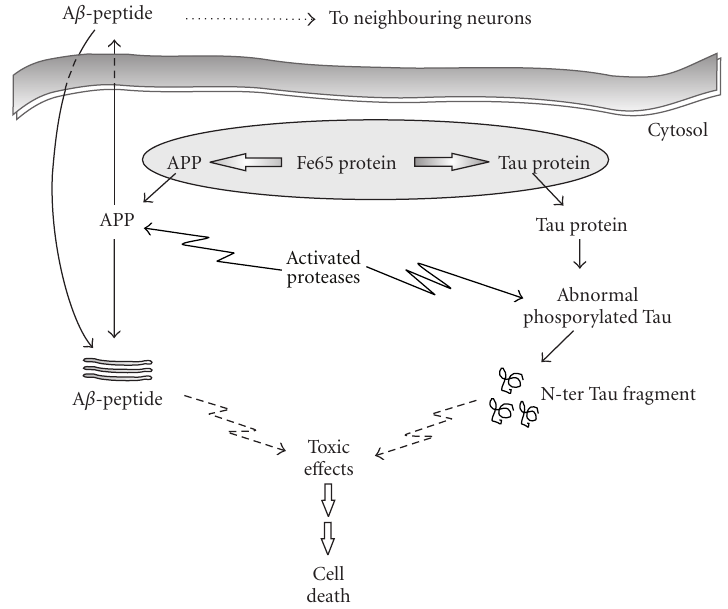
Figure 1: Schematic overview of A β peptide and Tau fragments production in CGNs. A β is produced intracellularly or taken up from extracellular sources and together with Tau fragments has various pathological e ff ects on cell